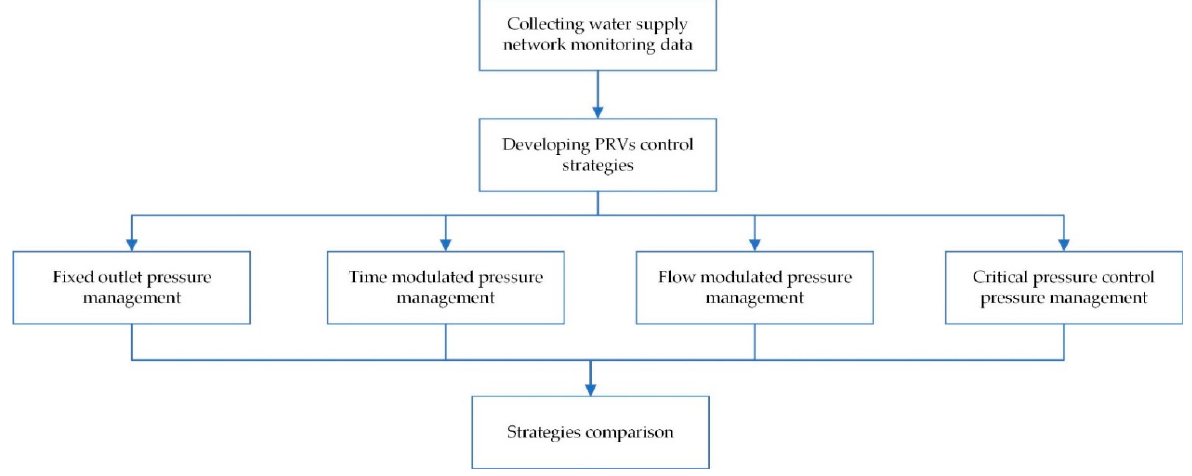
Figure 1. Intelligent pressure regulation technology.